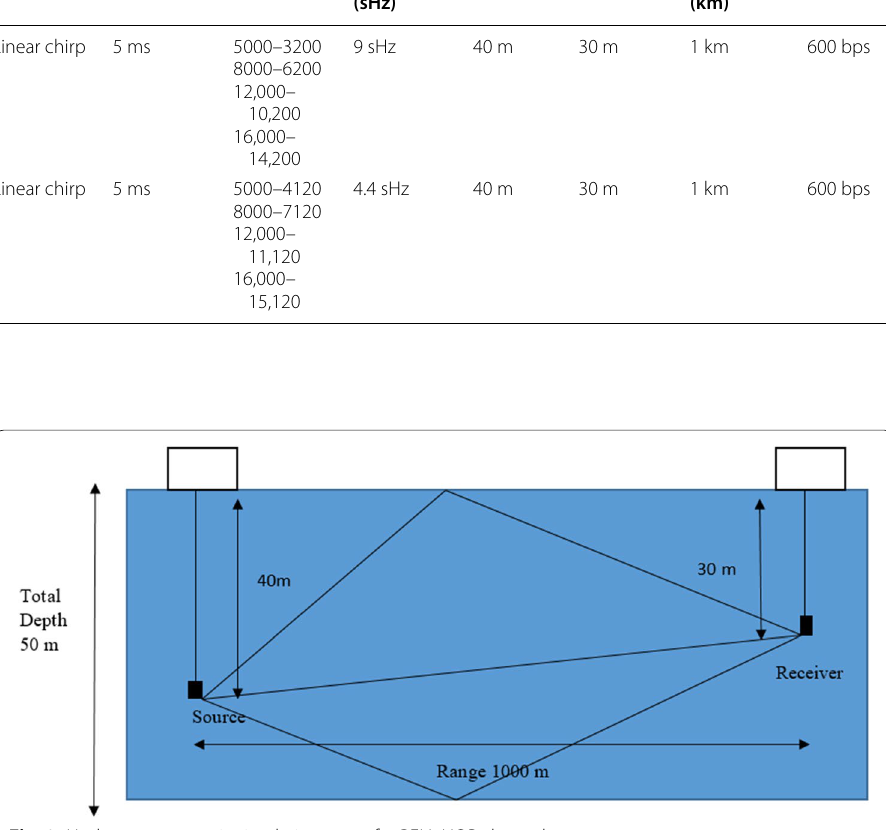
Fig. 9 Underwater acoustic simulation setup for BELL HOP channel